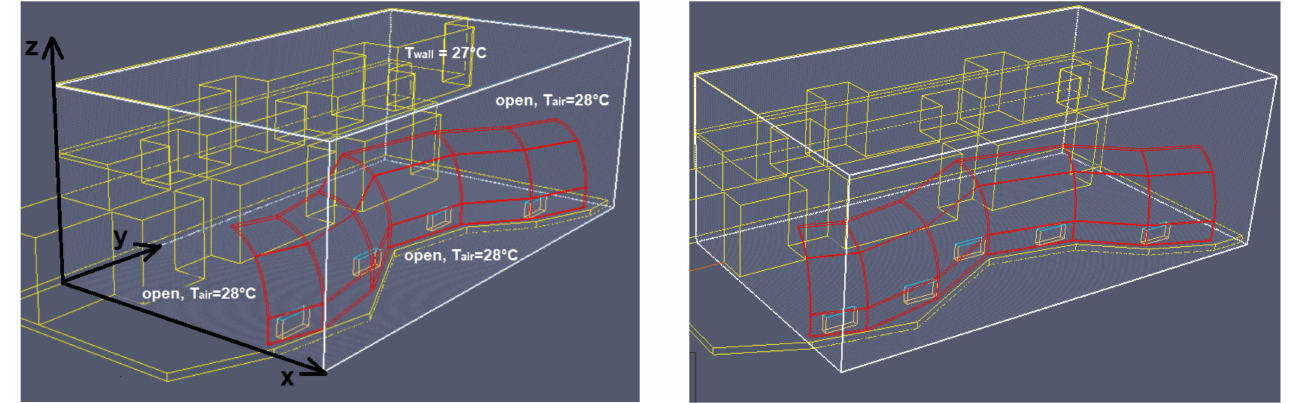
Figure 8. ( On the left ): reference configuration (4 fan coils and metallic carter) with boundary conditions. ( On the right ): the A configuration with the 5 fan coils.